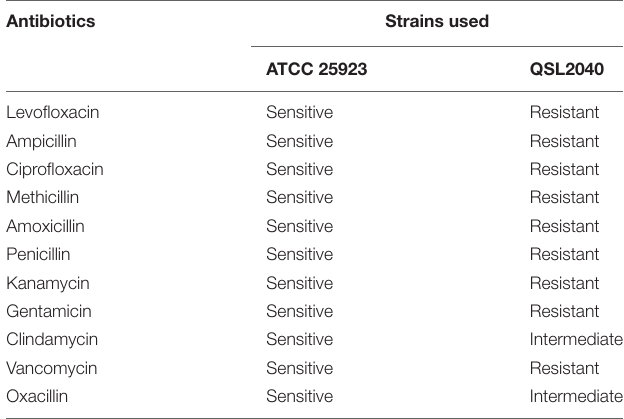
TABLE 1 | Antibiotic susceptibility profiling of the two strains used in the